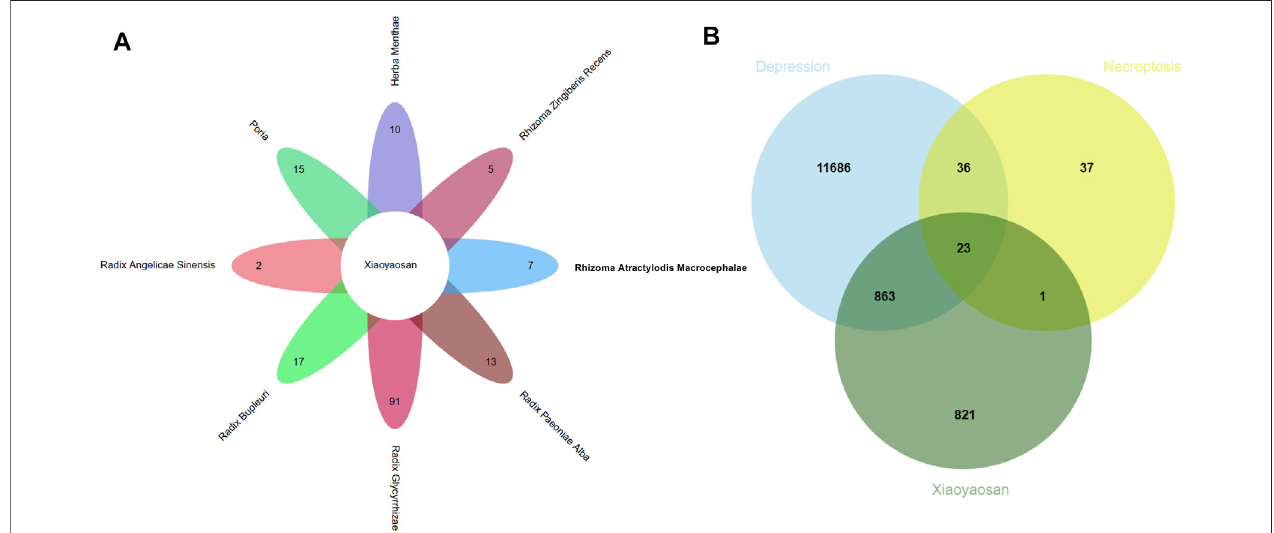
FIGURE 3 | Wynn maps for the active ingredients of Xiaoyaosan and potential treatment targets (A) Based on the ADME parameters (OB ≥ 30% and DL ≥ 0.18), therewere17ingredientsin RadixBupleuri ,twoingredientsin RadixAngelicaeSinensis ,13ingredientsin RadixPaeoniaeAlba ,15ingredientsin Poria ,seveningredients in Rhizoma Atractylodis Macrocephalae , 91 ingredients in Radix Glycyrrhizae , fi ve ingredients in Rhizoma Zingiberis Recens and 10 ingredients in Herba Menthae (B) A total of 1708 predicted targets of TCM formula Xiaoyaosan, 12,608 therapeutic targets for depression and 97 necroptosis related targets were intersected, and there were 23 potential treatment target